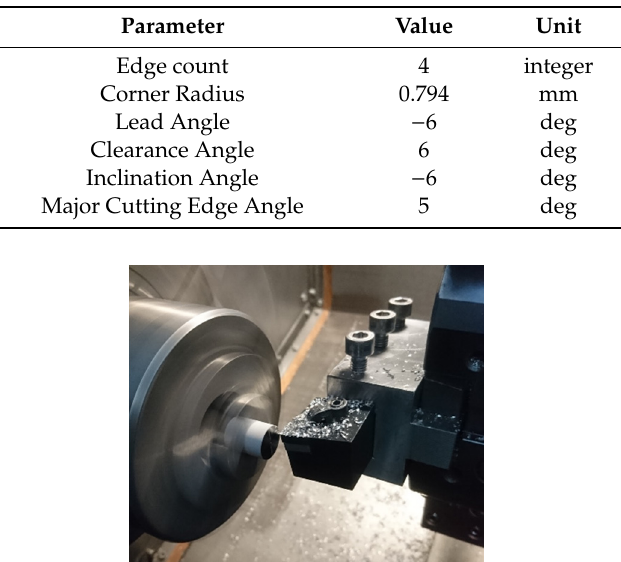
Table 2. E ff ective cutting tool (insert in tool holder) parameters. Table 2. Effective cutting tool (insert in tool holder) parameters.